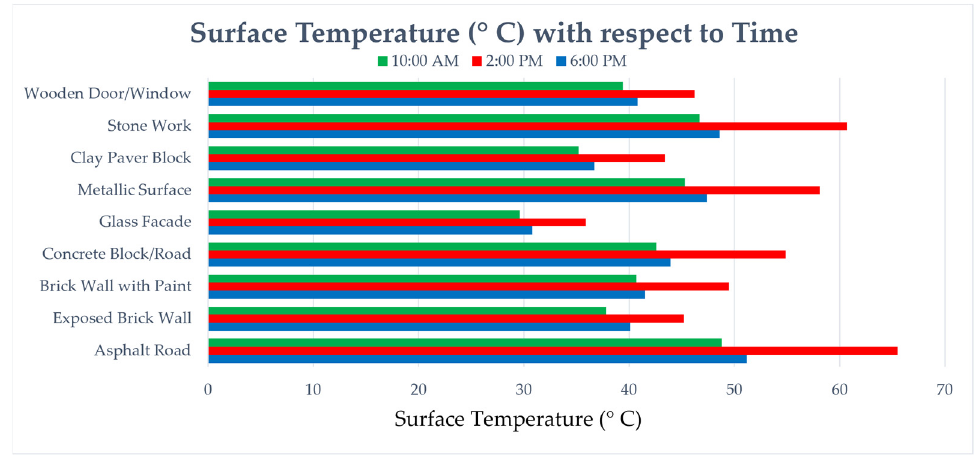
Figure 7. Recorded daily temporal data for the surface temperatures of various built-up materials in Mumbai.